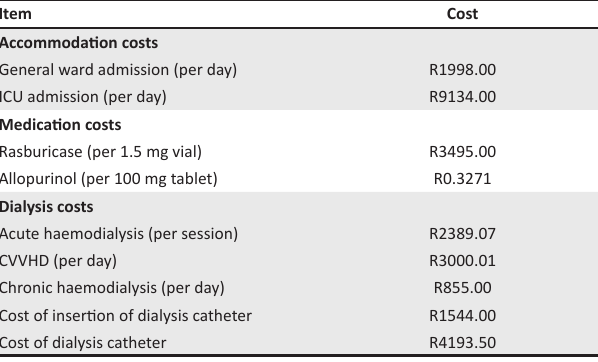
TABLE 3: Accommodation and treatment costs at Red Cross War Memorial Children’s